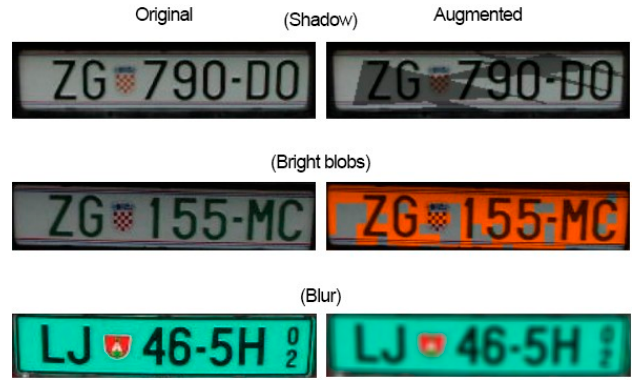
Figure 3. Data generation techniques on different license plates.